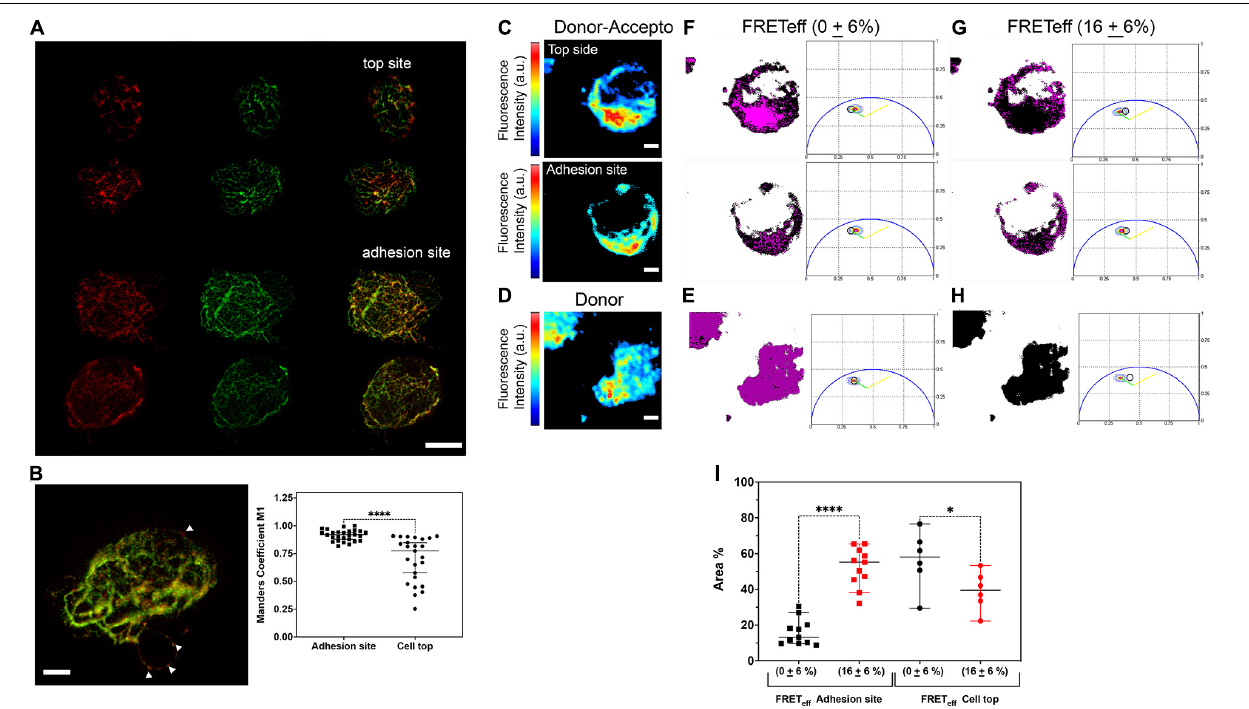
FIGURE 4 | MEC1 cells recapitulate the HS1 gradient of primary CLL cells. (A) Immunofluorescence 2D-STED images taken at the top and adhesion sites of representative MEC1 cells showing a colocalization gradient of endogenous HS1 and Vimentin. AntiHS1Ab568 (red), antiVimentinAb532 (green), and merged panels. Scale bar 4 µ m. (B) Representative 3D rendering of a Z-stack of a double HS1-Vimentin-immunostained MEC1 whole cell (left, white arrows point to the HS1 accumulation), and plot of Manders’ coefficients M1, proportional to the amount of fluorescence of the red channel (HS1) co-localizing with the green channel (Vimentin) in cell sections taken at the adhesion and top sites (right). Adhesion site 27 cells, top site 30 cells. Bars: mean ± SD. Mann–Whitney test P < 0.0001. Scale bar 2 µ m. (C–H) Representative two-photon phasor-FLIM-FRET analysis of immunostained endogenous HS1-Alexa488 (donor) and endogenous Vimentin-Alexa 546 (acceptor) in an MEC1 cell. Scale bars 4 µ m. (I) Scatter plot of the normalized cell areas with FRETeff either negligible (0 ± 6%) or equal to 16 ± 6% measured at the adhesion and top sites in single cells. Areas are reported as % ratio between number of pixels with FRET (pink mask as in panels E–H ) over the total image area (black mask as in panels E–H ) at the adhesion and top sites. Bars: mean ± SD. ∗∗∗∗ P < 0.0001; ∗ P = 0.0466. Adhesion site (0 ± 6%) and (16 ± 6%): 11 cells; Top site (0 ± 6%) and (16 ± 6%): 6